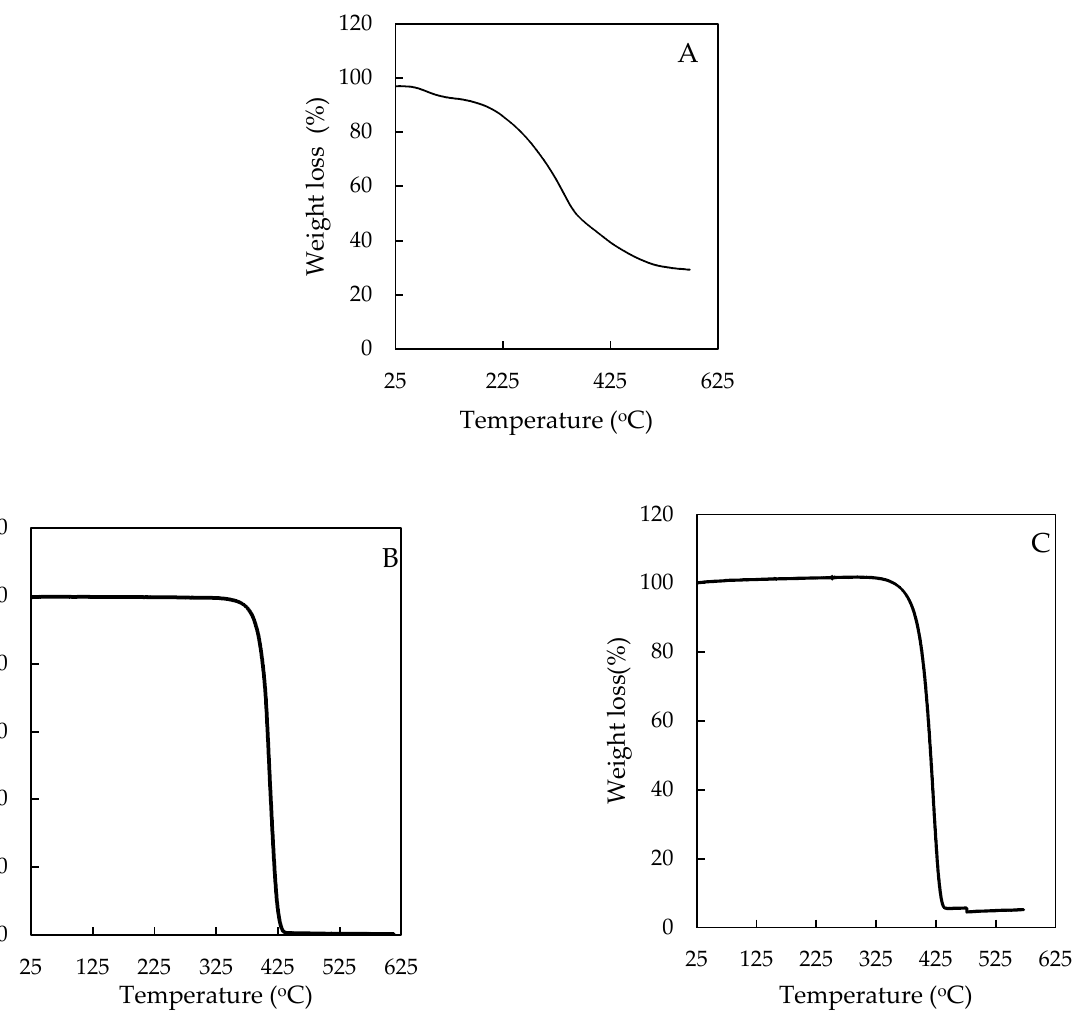
Figure 6. Thermogravimetric curves of ( A ) MOLP, ( B ) PEG4000, and ( C ) PEG6000 at a heating rate of 10 ◦ C · min − 1